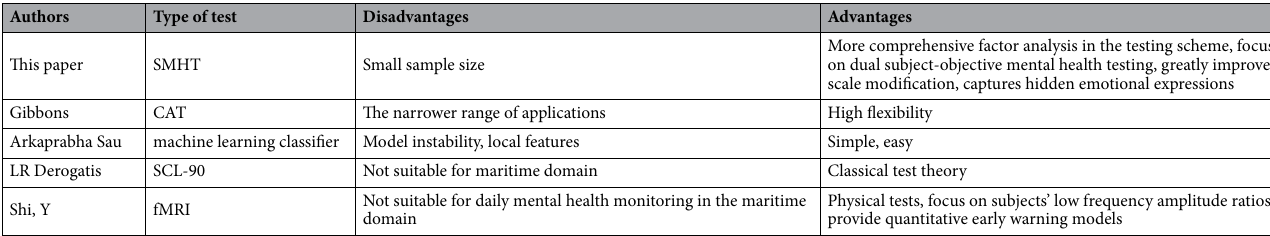
Table 2. Comparison of the advantages and disadvantages of SMHT with the representative four